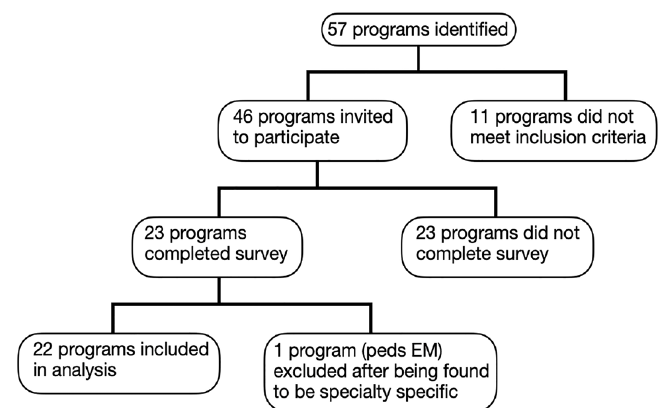
Figure 1. Global Emergency Medicine fellowship programs included. EM , emergency